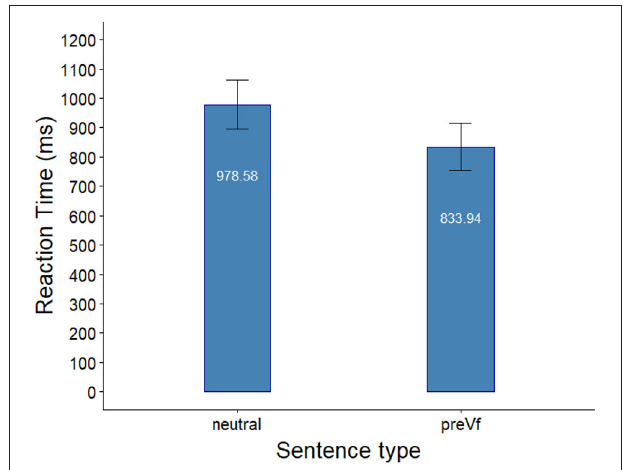
FIGURE 3 | Response latencies in the same-condition in Experiment 2. Error bars indicate the standard error of the mean.